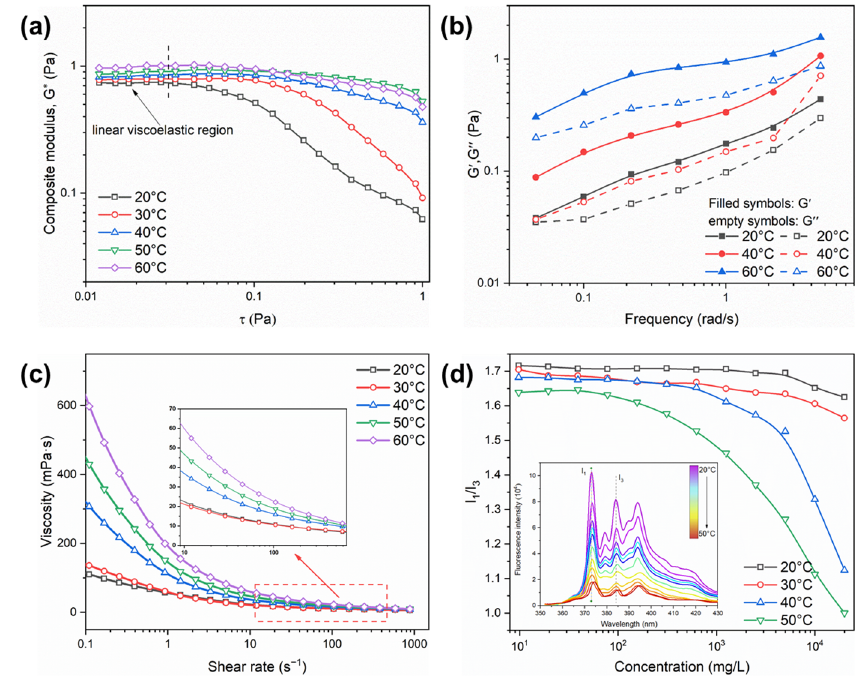
Figure 3. Viscoelastic behavior ( a ), the storage modulus (G ′ ), loss storage modulus (G ″ ) as a function of frequency ( b ), viscosity as a function of shear rate (linear axes) ( c ) of 1.0 wt% PAND solution at different temperature. ( d ) The I1/I3 curve as a function of PAND concentration at different temperatures.